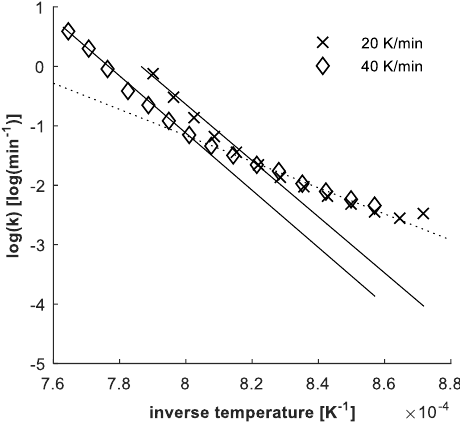
Figure 3. Arrhenius plot for CO₂ gasification in configuration No. 1 with 20 K/min and 40 K/min heating rate.